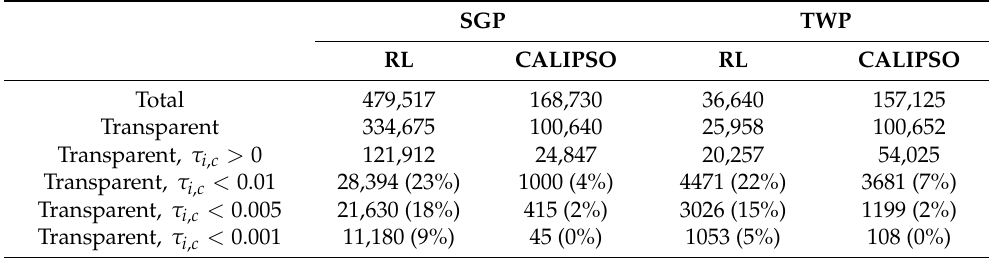
Table 1. Number of total available profiles, transparent profiles, and transparent ice cloud profiles (i.e., transparent profiles where ice clouds are detected) for the RL and CALIPSO at the SGP and TWP sites. For the transparent ice cloud profiles, the number of profiles with ice cloud column optical depths greater than 0 (i.e., all transparent ice cloud profiles), less than 0.01, less than 0.005 and less than 0.001 are given. The numbers in the parentheses are the fraction relative to the number of all transparent ice cloud profiles. Data for the RL at the SGP site are from August 2008 to August 2016 and at the TWP site from December 2010 to January 2015. Data for CALIPSO for both the SGP and TWP sites are from June 2006 to August 2016.